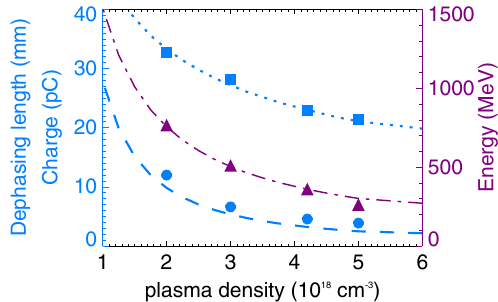
FIG. 2. Variation of dephasing length (blue circles, left axis), trapped charge (blue squares, left axis) and beam energy (purple triangles, right axis) as a function of plasma density when the laser dimensions scale proportionally to the plasma wavelength. The blue dashed line shows the theoretical dephasing length ∼ λ 3 L = 2 λ 2 0 ∝ 1 =n 3 = 2 0 , the blue dotted line shows the scaling of p d the charge corresponding to the same amount of beam loading Q ∝ 1 =n 1 = 2 0 and the purple dash-dotted line shows the scaling for the energy gain E ∝ 1 =n 0